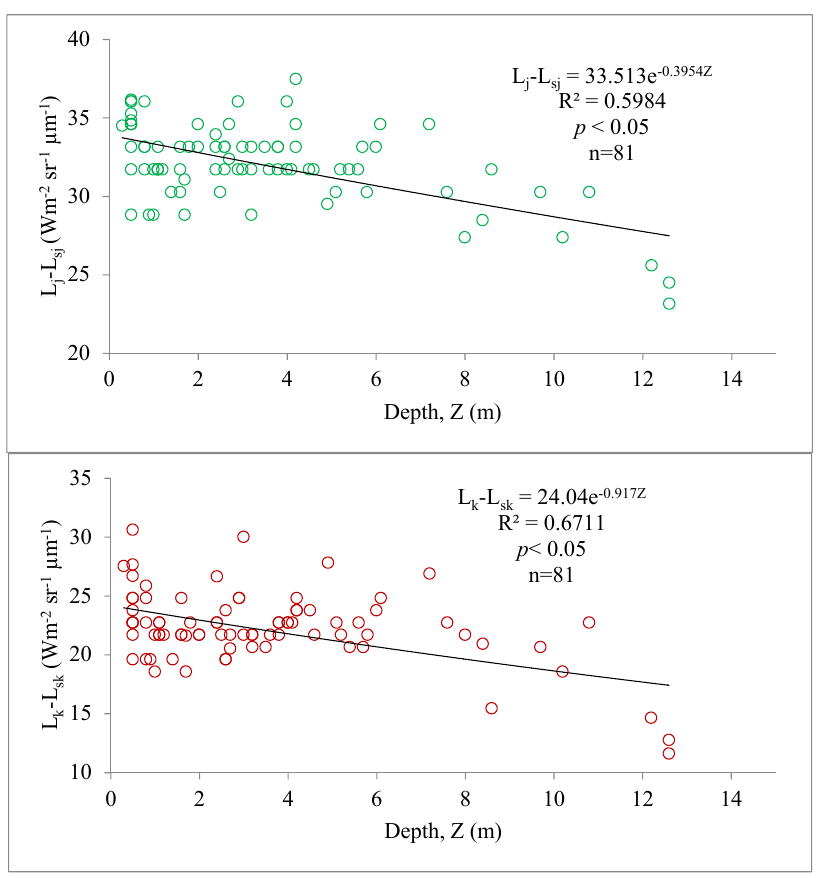
Figure A1. The attenuation coefficient of blue, green and red TM band.